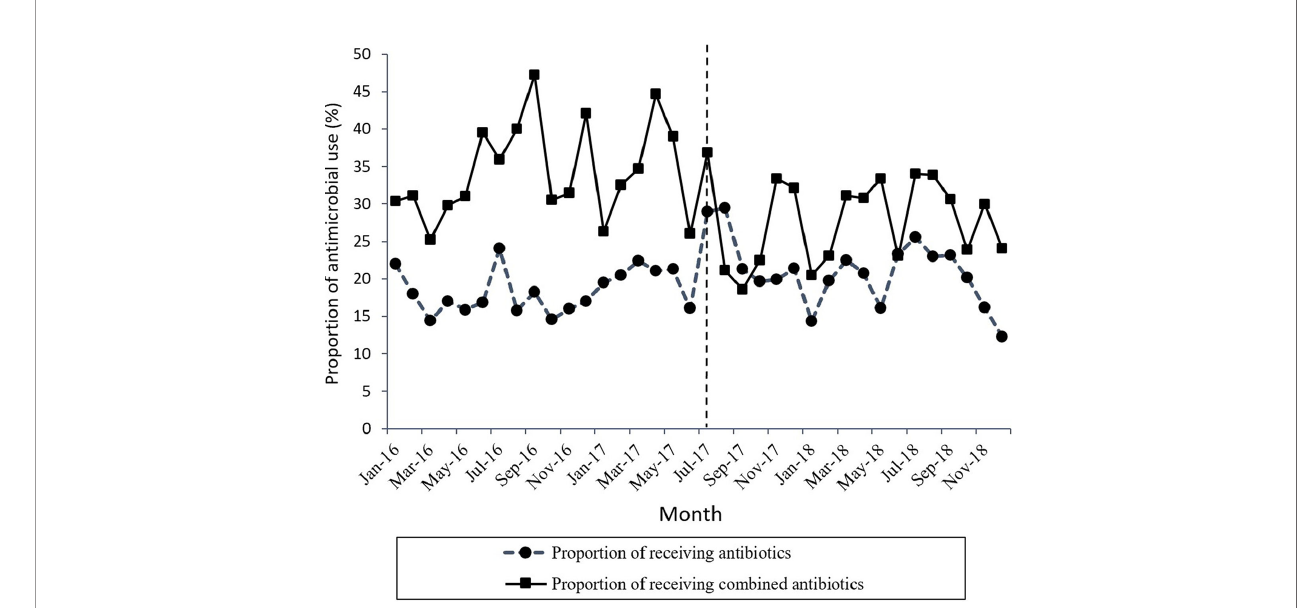
FIGURE 2 | The change in the proportion of receiving antibiotics and the proportion of receiving combined antibiotics per month pre- and post-intervention. The vertical line separated two segments (before and after the MPL